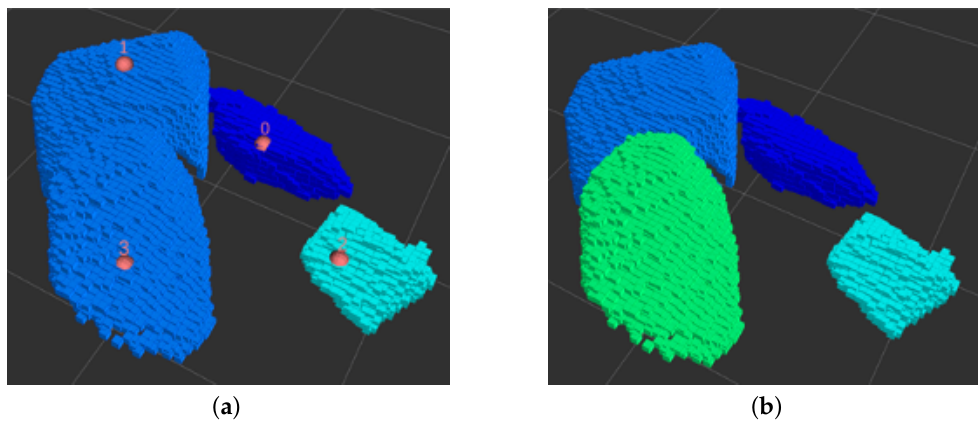
Figure 4. Example of correction in point cloud rock segmentation using image-based detections. ( a ) Segmented point cloud, and center projection of the ellipses detected in images. ( b ) Segmentation of the point cloud corrected from the information provided by the centers of the ellipses.